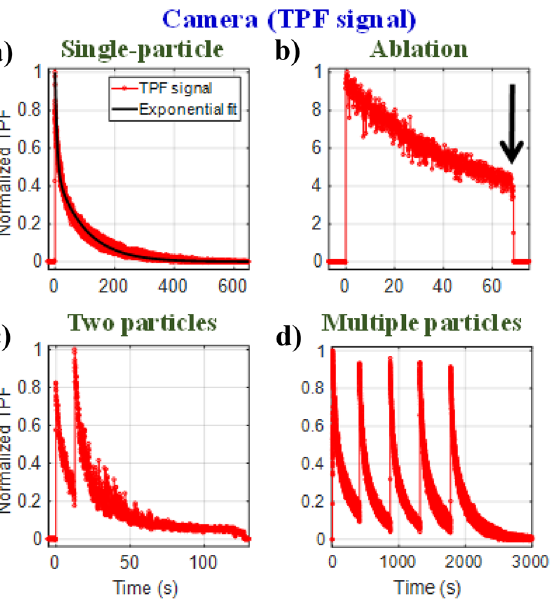
Figure 1. TPF signal from ( a ) trapped single-particle, ( b ) ablation for stuck particle (indicated by an arrow), ( c ) two-particles and ( d ) multiple